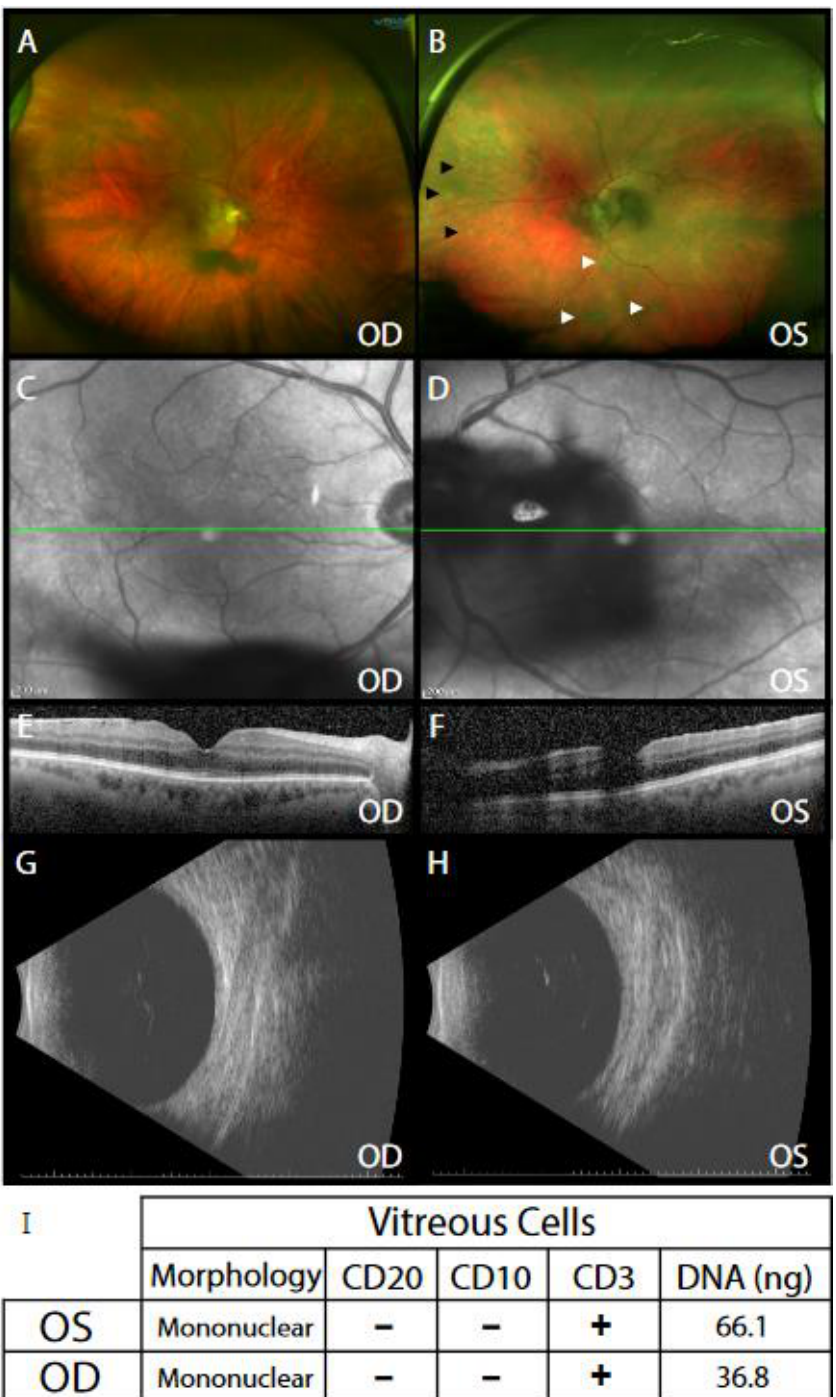
Figure 1. Clinical examination shows vitreous debris in both eyes. ( A ) Ultra-widefield retinal imaging of the right eye (OD) showed vitreous clumps over the posterior pole. ( B ) Ultra-widefield retinal imaging of the left eye (OS) showed vitreous cells (black arrowheads); inferior snowballs (white arrowheads); and dense vitreous clumps over the posterior pole. ( C , D ) Infrared en-face imaging shows level (green-line) at which optical coherence tomography (OCT) was used to image cross-section of macula ( E , F ). Cross-sectional OCT showed ( C ) mild epiretinal membrane OD and ( D ) a dense vitreous opacity over the macula OS. Posterior B-Scan ultrasonography revealed vitreous opacities ( G ) OD and ( H ) OS. ( I ) Cytological examination for morphology and cell-surface marker staining for CD20, CD10 and CD3 as well as vitreous DNA amounts are shown for each vitreous sample.